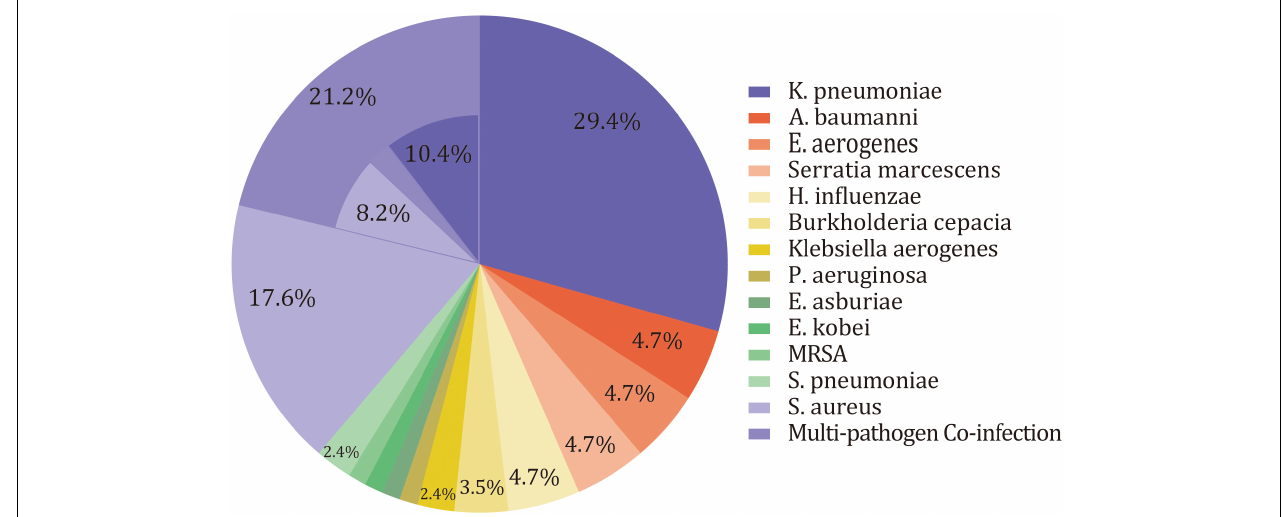
FIGURE 2 | Pie chart of distribution of microbiology of SAP for critically ill patients.